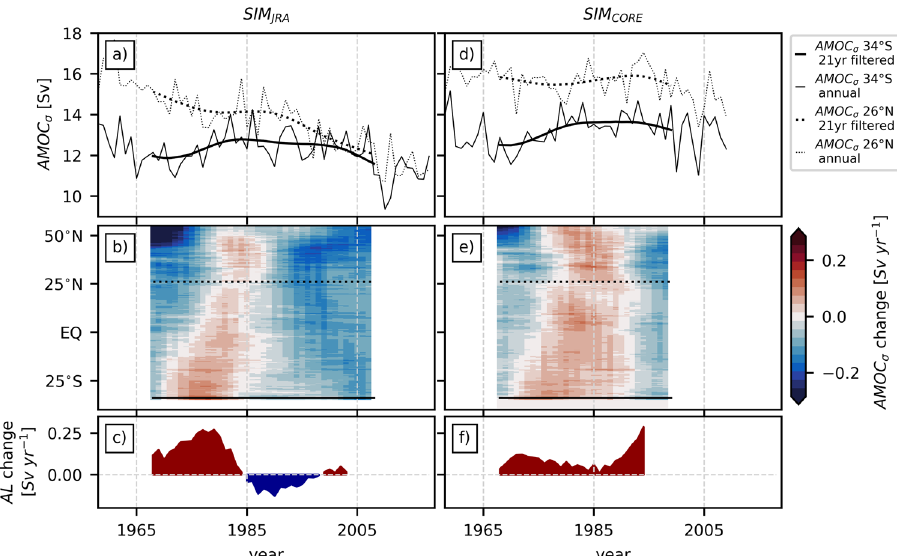
Hamming window) strength of the AMOC in density coordinates (AMOC σ ) at 34°S (solid lines) and at 26°N (dashed lines). b Annual rate of change in decadally fi ltered AMOC σ strength as a function of time and latitude. c Annual rate of change in decadally fi ltered AL strength, as simulated with SIM JRA . d – f Same as panels a to c but for SIM CORE